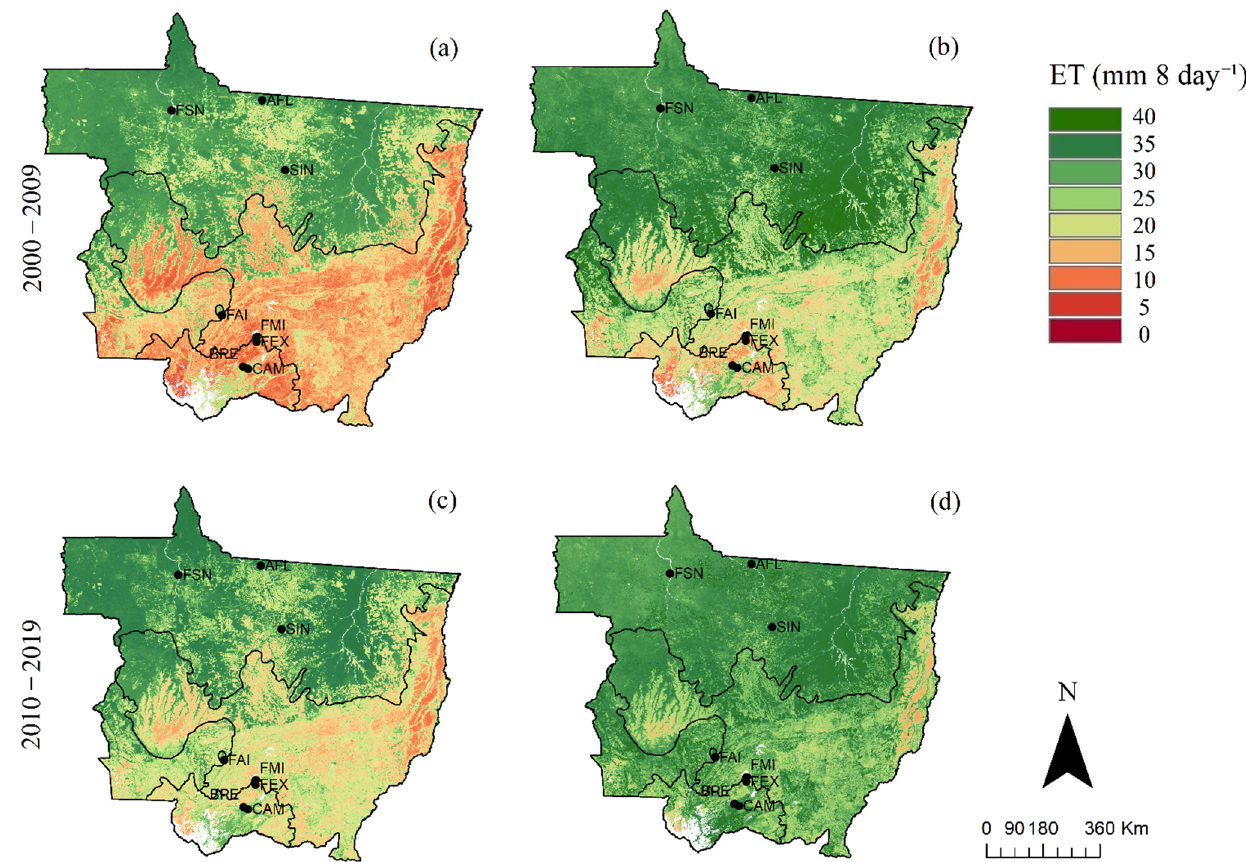
Figure 7. Averaged ET MODIS during the dry (May–September; panels a , c ) and wet seasons (October– April; panels b , d ) in 2000–2009 (panels a , b ) and 2010–2019 (panels c , d ).